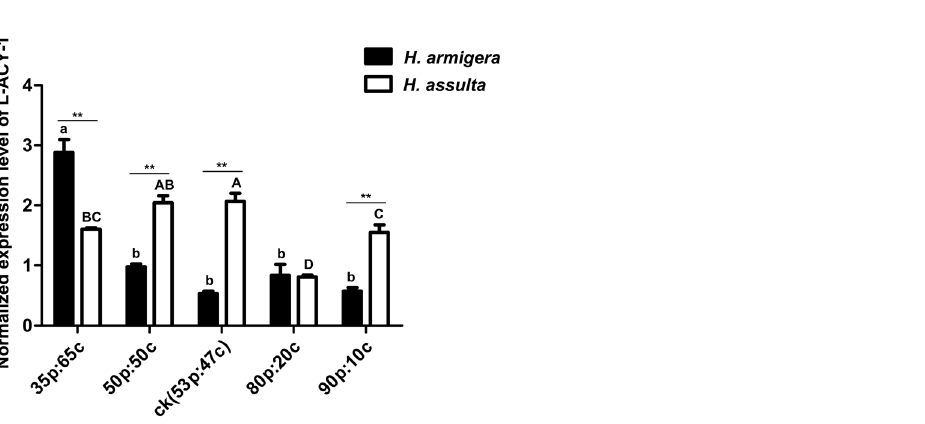
Figure 5. Effects of allelochemicals on the expression of L-ACY-1 in H. armigera and H. assulta . The data and error bars represent the means and standard deviations of three biological replicates of three technical repeats each. Values sharing the same letter [small case letters for H. armigera , capital letters for H. assulta ] are not significantly different at p < 0.05 (Tukey’s HSD tests). Significant differences at each of the four treatments between the two species are indicated by one star ( * p < 0.05, independent t-test) and two stars ( ** p < 0.01, independent t-test), respectively.